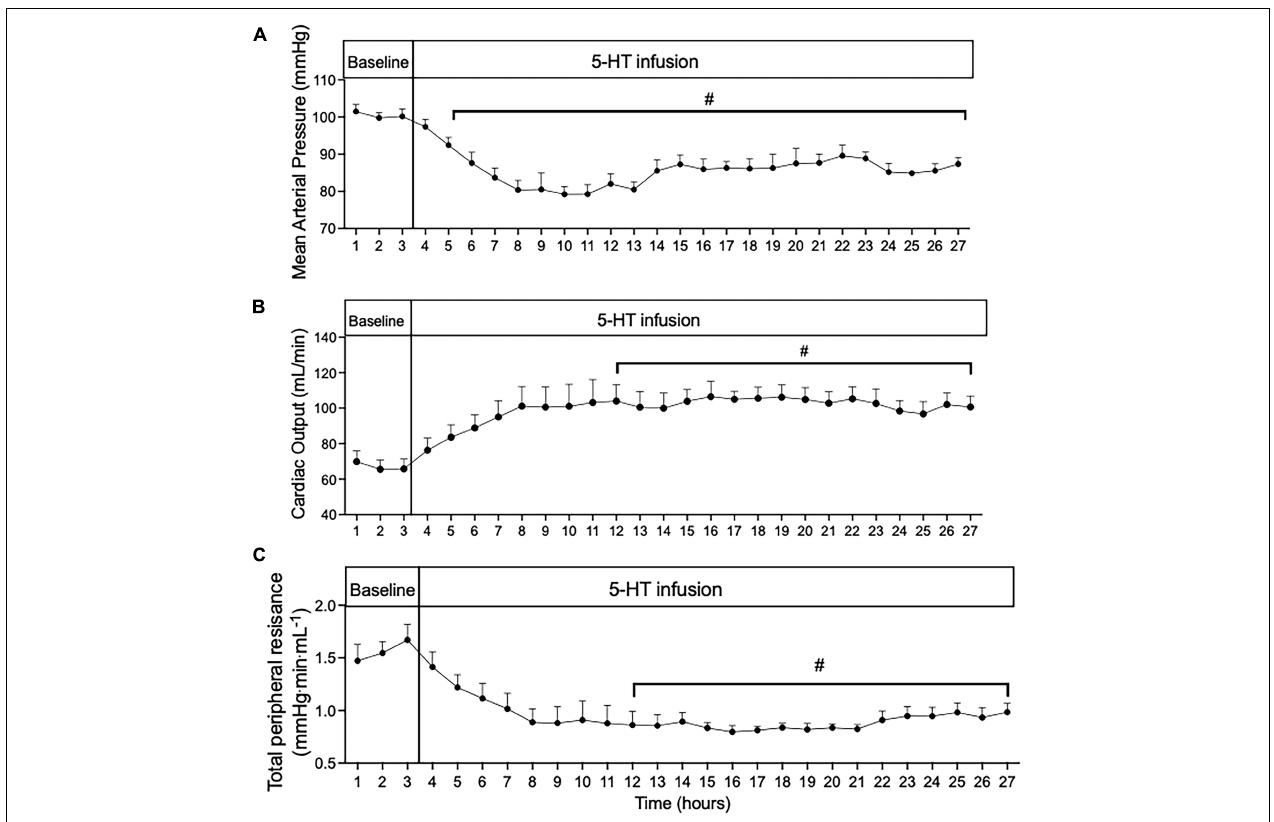
FIGURE 2 | Time course of (A) mean arterial pressure; (B) cardiac output; and (C) total peripheral resistance during 24 h of 5-HT infusion in conscious rats. Data points represent 1-h averages ± SEM; n = 5. A one-way ANOVA with repeated measures was used to determine significant differences ( # p < 0.05) compared to baseline. Baseline represents the average of the 3 h prior to the start of 5-HT